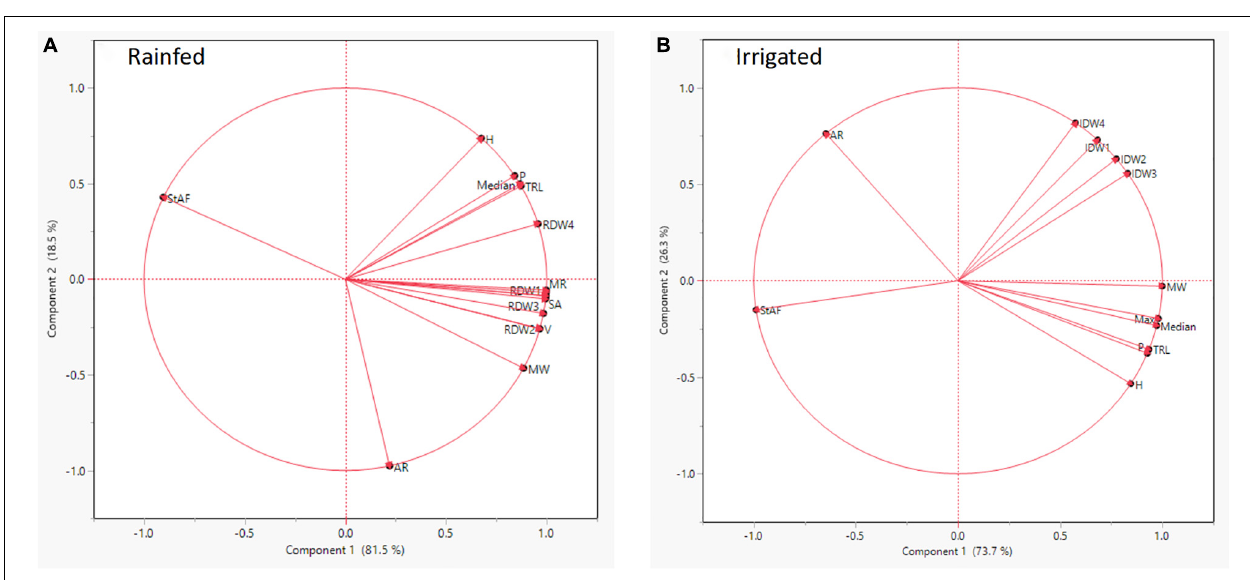
FIGURE 8 | Correlation of statistically significant root architectural traits identified in rainfed (A) and irrigated (B) conditions with dry biomass yield in alfalfa populations